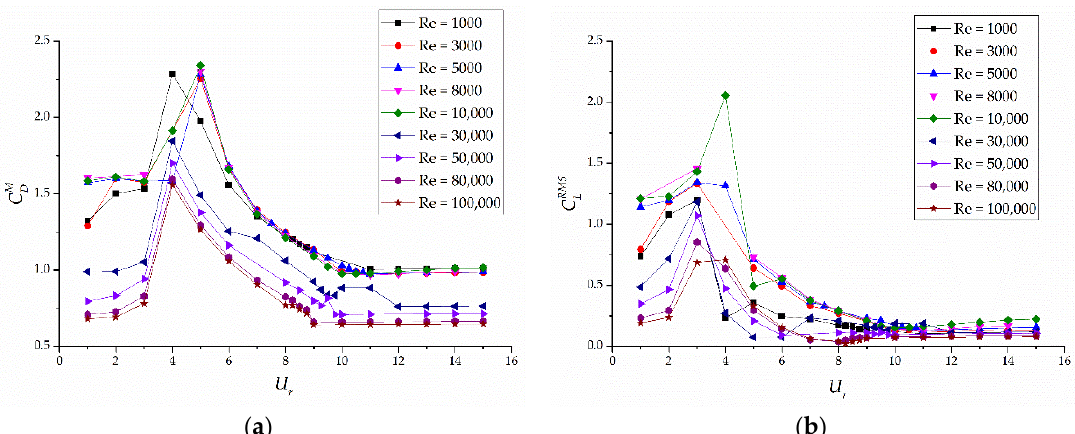
Figure 12. Non-dimensional force coefficient on SFT versus natural frequency at different Reynolds numbers: ( a ) mean drag coefficient; ( b ) RMS of lift coefficient.